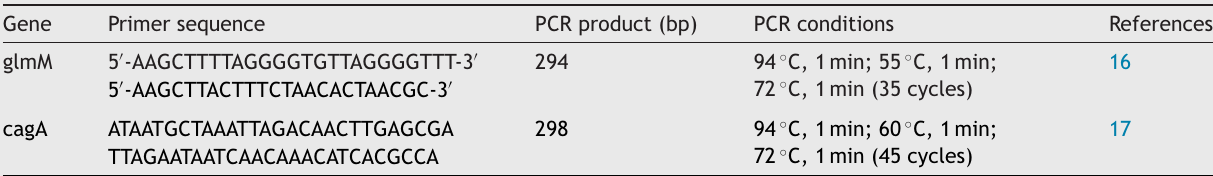
DNA primers used and the amplification